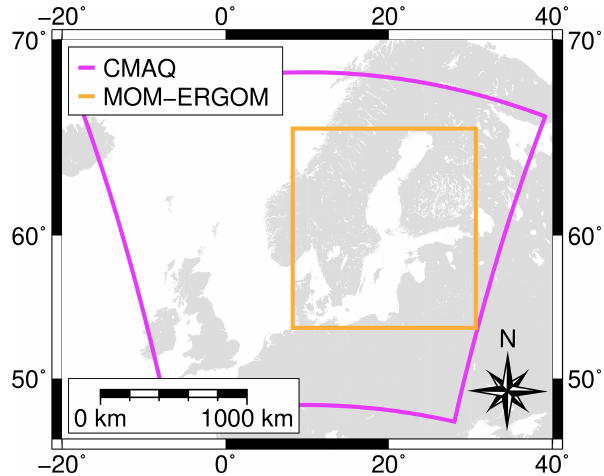
Figure 1. Extent of the model domains of the atmospheric chem- istry transport model (CMAQ) and of the marine biogeochemical model